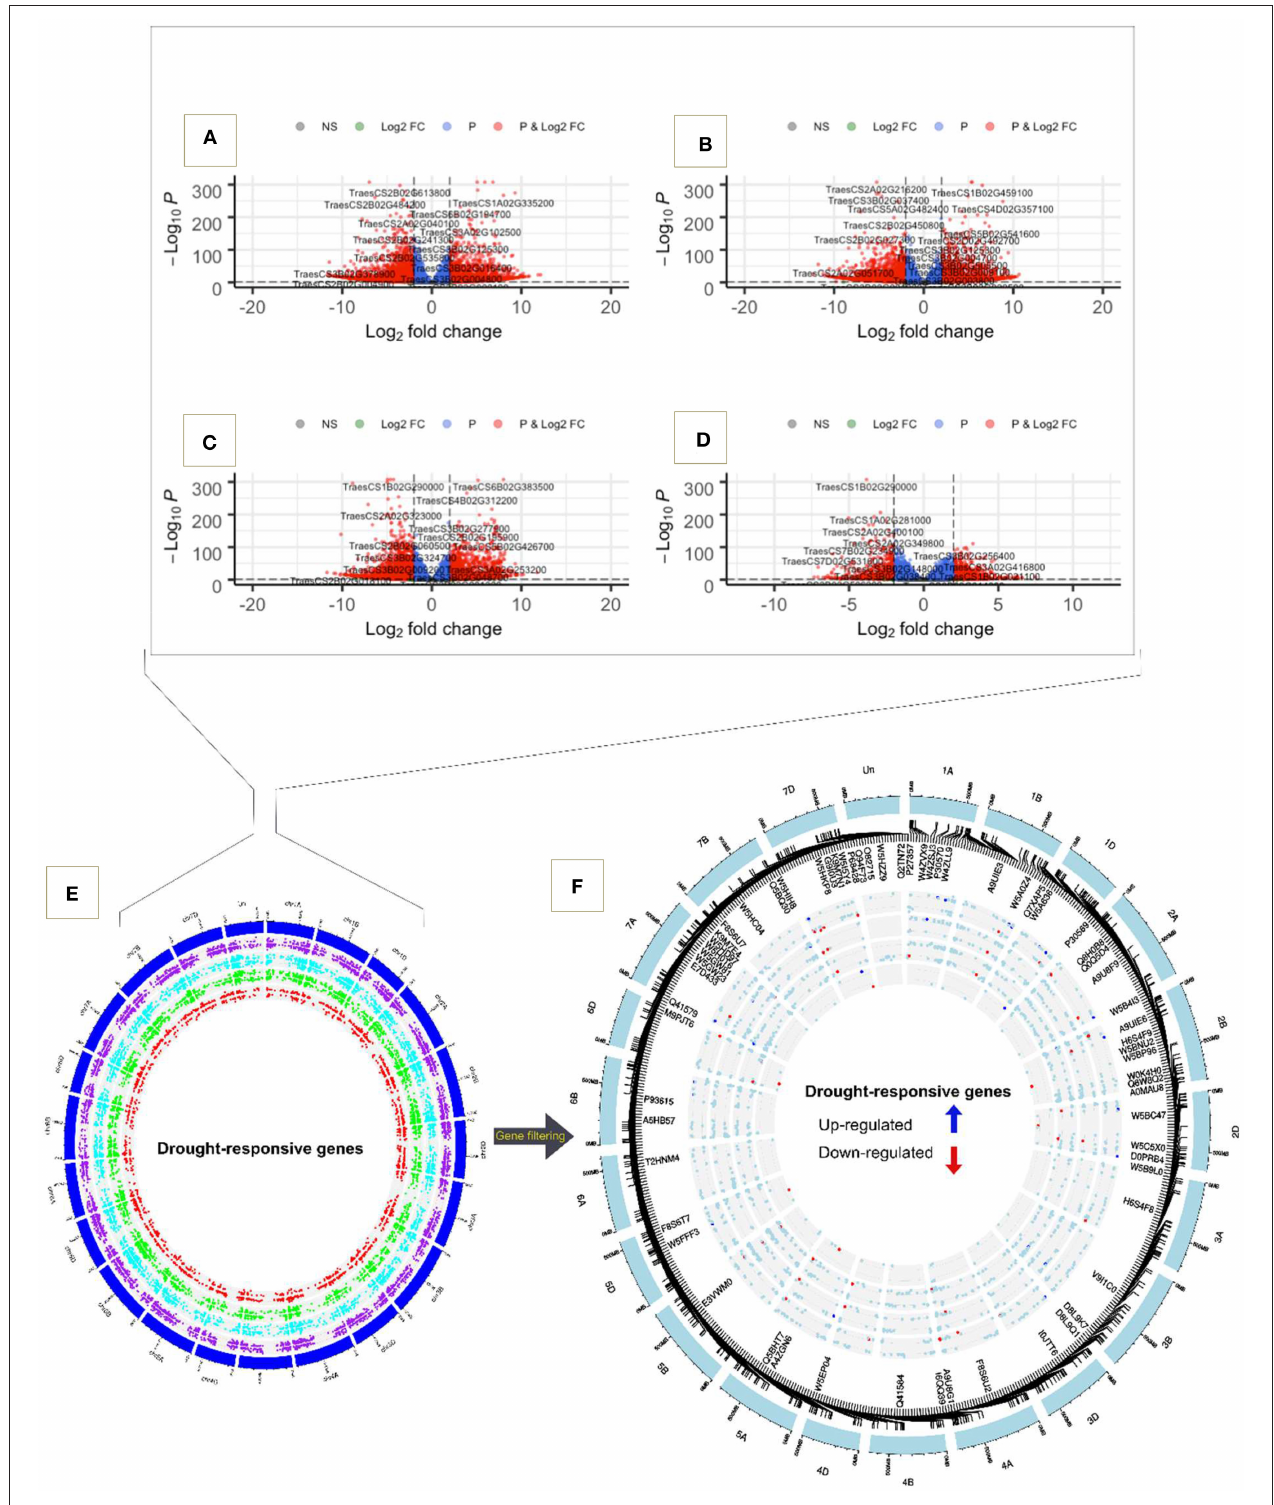
FIGURE 3 | Volcano plot and chromosome wise distribution of highly significant up and down-regulated genes. (A) PI627299 (T) vs. PI624837 (S). (B) PI627038 (T) vs. PI624837 (S). (C) Water deficit vs. control. (D) Time-point 18 DA vs. 9 DA. (E) Circos plot of all significant genes, in comparison 1/ PI627299 (T) vs. PI624837 (S) (purple spots), in comparison 2/ PI627038 (T) vs. PI624837 (S) (light blue spots), in comparison 3/ condition water deficit vs. control (green spots), and in comparison 4/ time-point 18 DA vs. 9 DA (red spots). (F) Chromosomal region of important key genes and their encoding proteins are shown inside the plot.